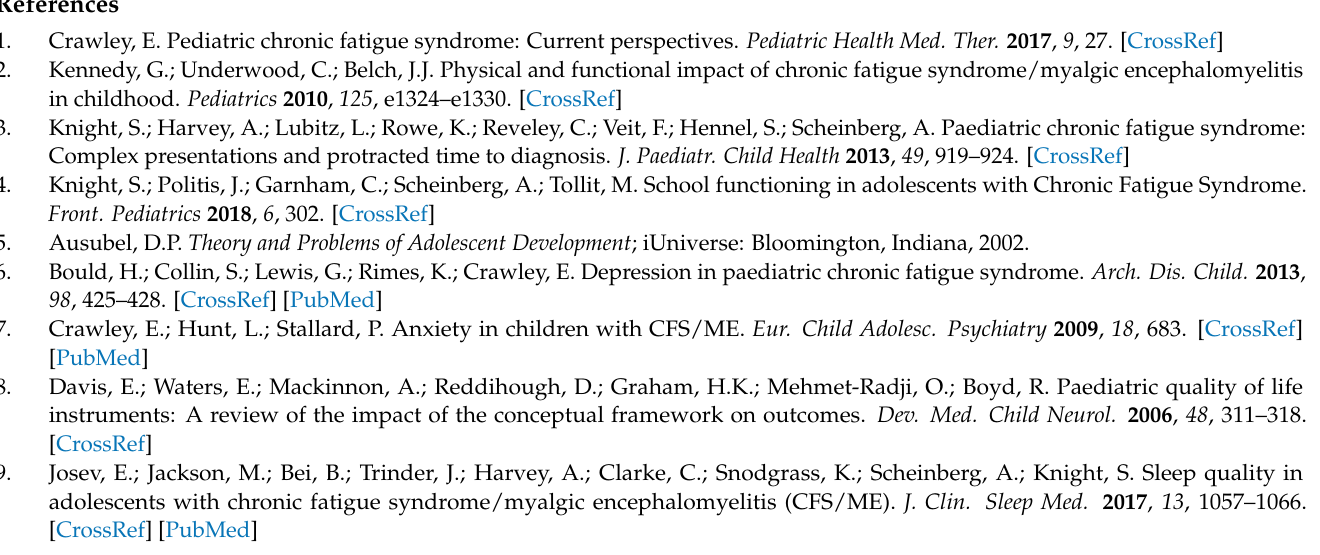
Table S3: Participants who fulfilled paediatric ME/CFS diagnostic criteria at baseline and follow-up, Table S4: Pearson correlation matrix between health and psychological wellbeing measures and fulfilment of paediatric ME/CFS diagnostic